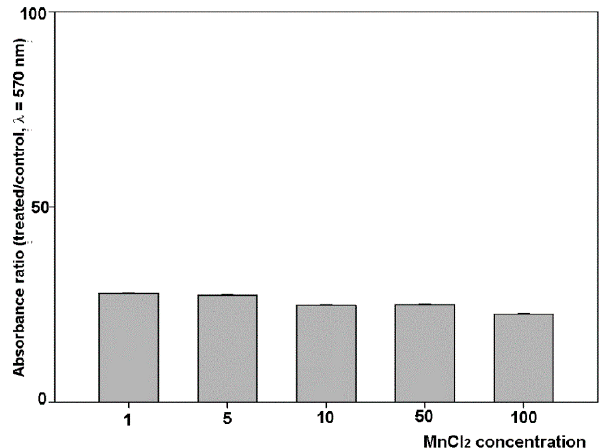
Figure 3. Effect of coexposure of MDA-MB231 cells to both 5 µM CdCl 2 and different concentrations of MnCl 2 for 96 h. The histogram shows the percent ratio between the crystal violet absorbance of coexposed cells and that of controls, i.e., cells treated with the sole MnCl 2 at the indicated concentrations. Results are from quadruplicate crystal violet assays. Four replicates were run for each assay. The results are expressed as the mean ± standard error of the mean (SEM).